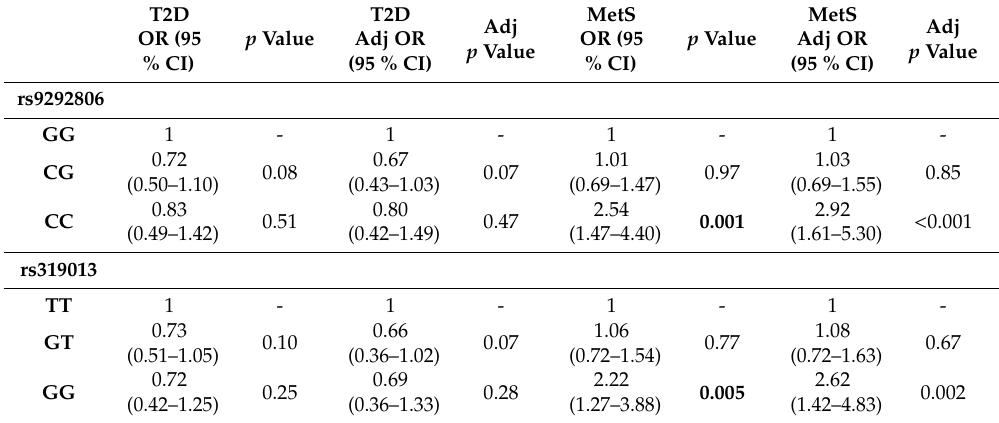
Table 4. Odds ratios of genotypes the PLCXD3 SNPs in control vs. T2DM and Non-MetS vs. MetS